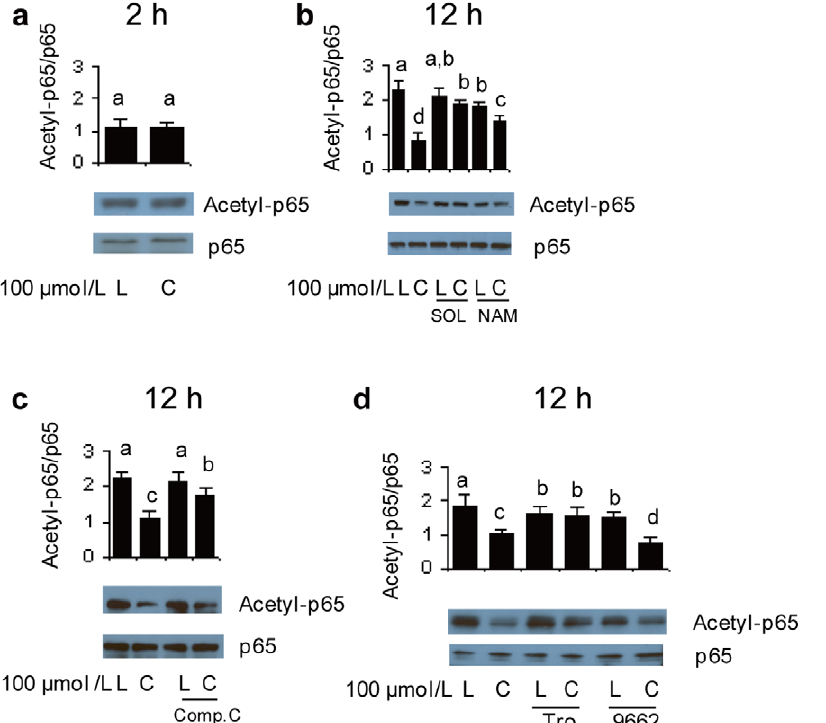
Figure 6. SIRT1, AMPK and PPAR c affect the t 10 c 12 CLA-dependent decrease in the amount of acetylated NF- k B. The amount of acetylation on the p65 subunit of NF- k B or the total amount of p65 in nuclear extracts was detected by immunoblot analysis with antibodies specific for acetylated p65 or total p65. The ratio of the acetylated to total p65 is shown in the bar graphs (Acetyl-p65/p65). a–c Differentiated 3T3-L1 adipocytes were incubated with 100 m mol/L LA (L) or t 10 c 12 CLA (C) a for 2 h, or b for 12 h, with or without sirtuin inhibitors sirtinol (SOL) or nicotinamide (NAM), or c with or without AMPK inhibitor compound C (Comp.C). d The effects of PPAR c agonist troglitazone (Tro) or PPAR c antagonist GW9662 (9662), in combination with LA or t 10 c 12 CLA, on the acetylation of the p65 subunit of NF- k B was measured. Each bar in panels a–d represents the mean + SEM (n=3) of three independent experiments. Means not sharing a common letter differ, P ƒ 0.05.